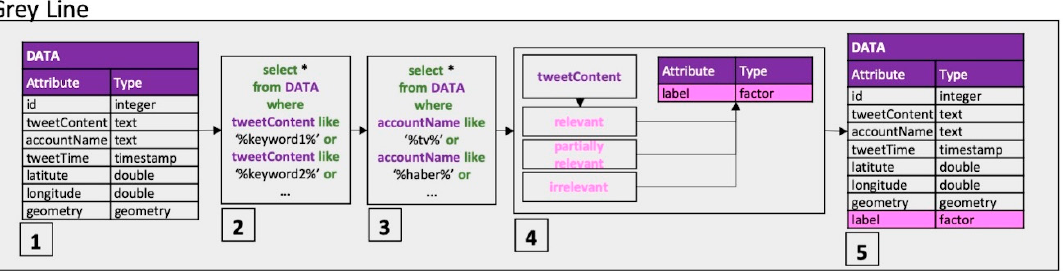
Figure 2. The grey line for data tidying.